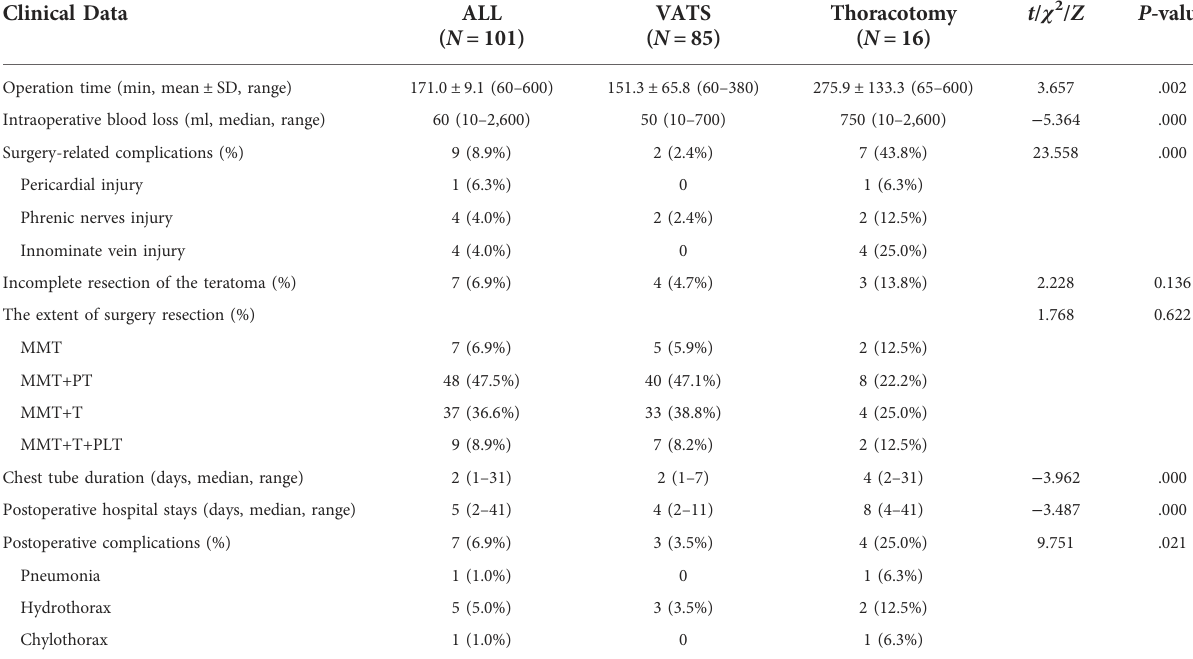
TABLE 4 Perioperative and postoperative results of the patients with mediastinal mature teratoma.